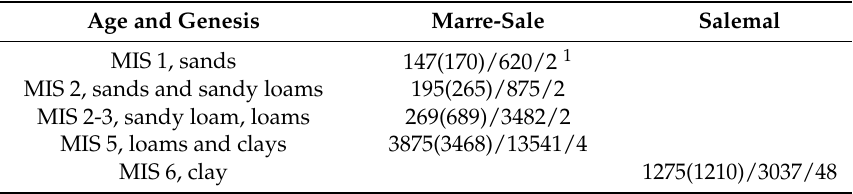
Table 2. Methane concentration (ppmV) in typical permafrost sediments of the study region.